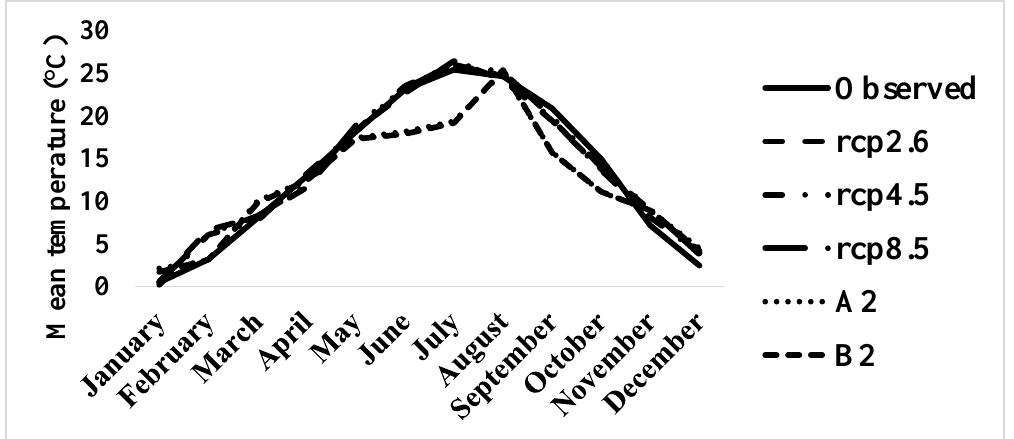
Figure 2. Results of the comparison between the observed and simulated monthly mean temperature values (2006–2015). Table 1. Properties of the used standard Intergovernmental Panel on Climate Change [10] scenarios.